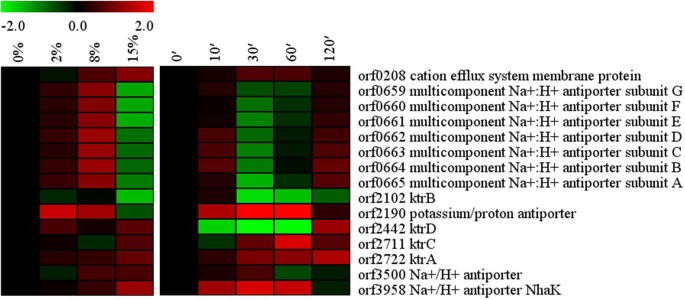
Alterations in K+ uptake and Na+ efflux related genes.Expression profiles are displayed on the basis of log2 ratios.